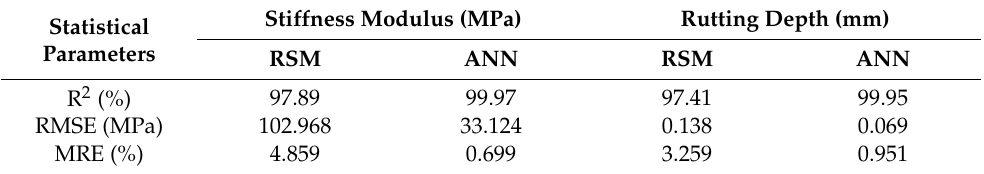
Table 11. Comparison of RSM and ANN statistical performance index